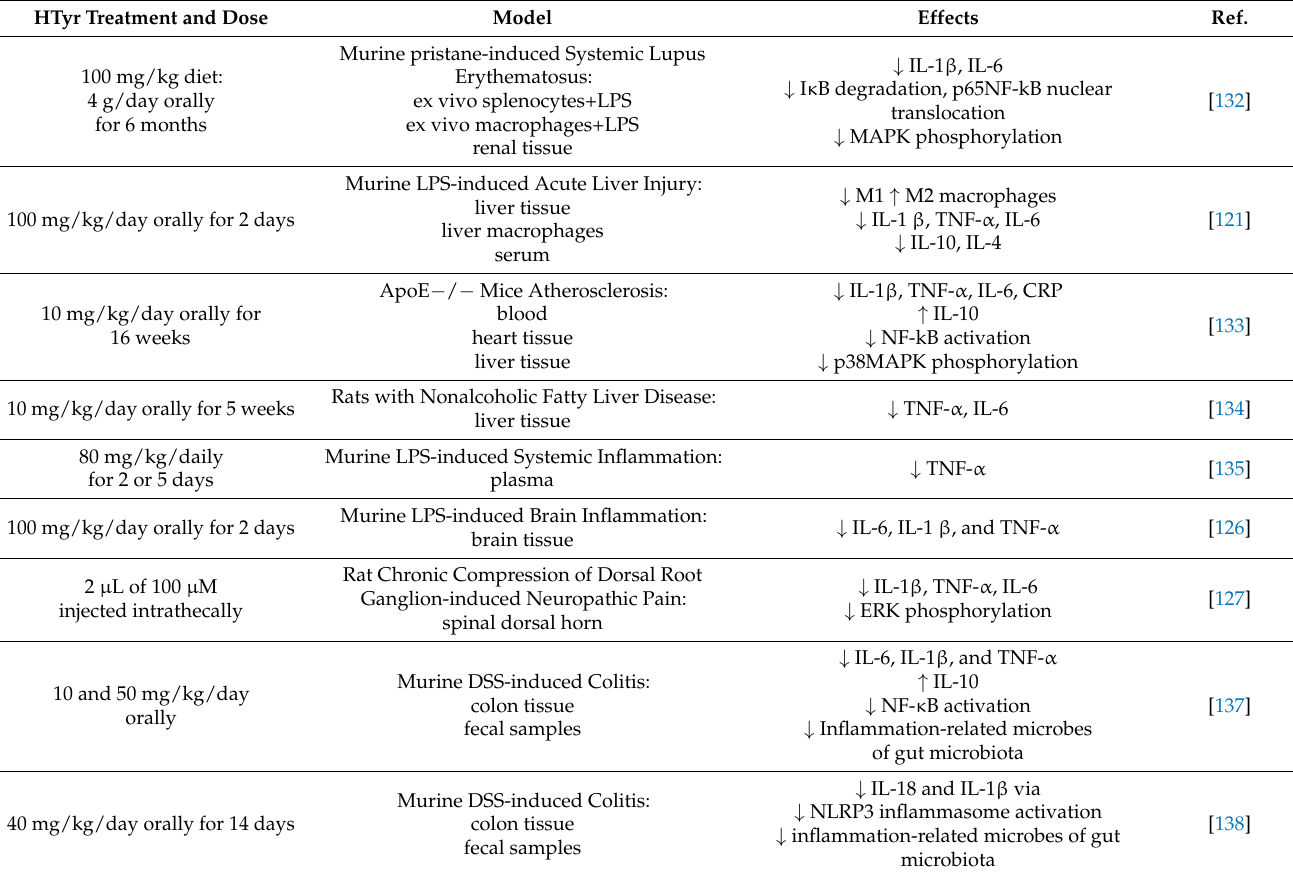
Table 2. In vivo effects of HTyr on